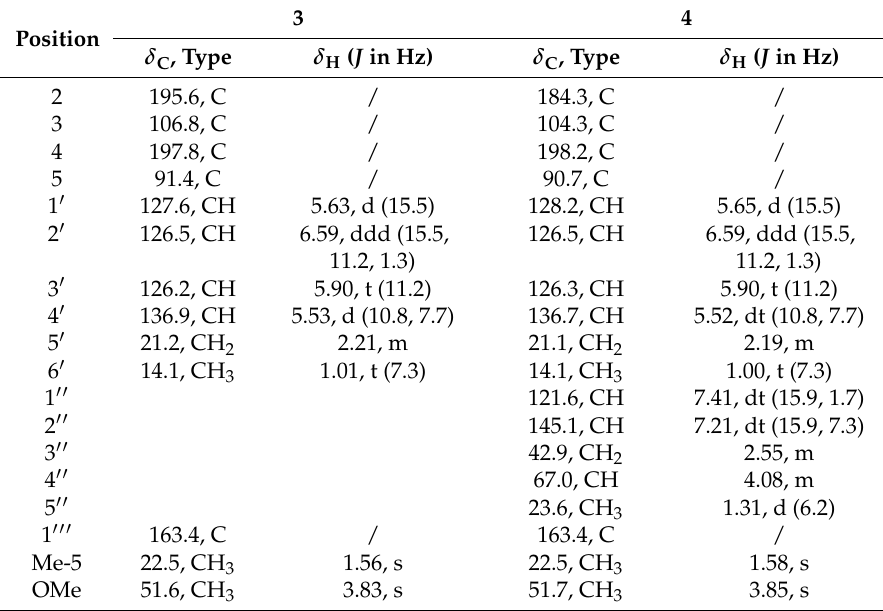
Table 1. 13 C- and 1 H-NMR spectroscopic data of Compounds 3 and 4 (175 and 700 MHz, resp.; CDCl 3 ; δ in